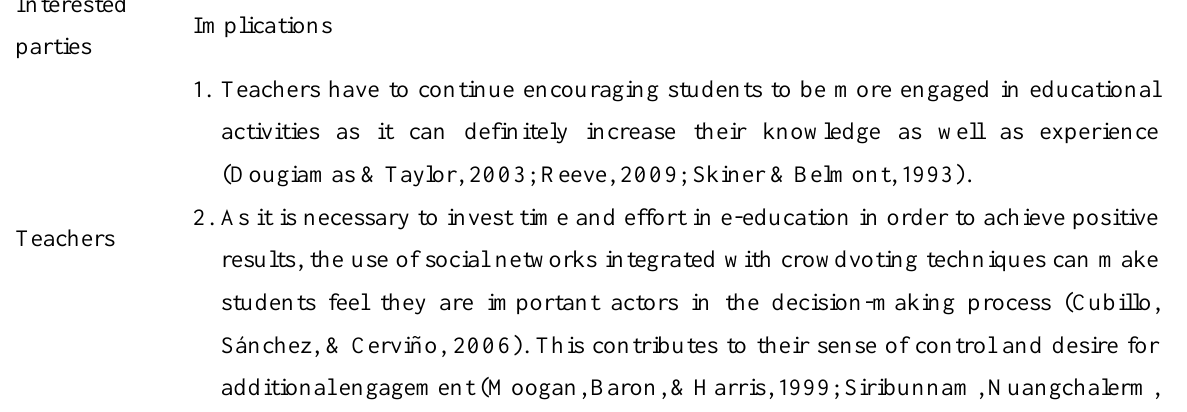
Implications for Teachers, Education Practitioners, and Students